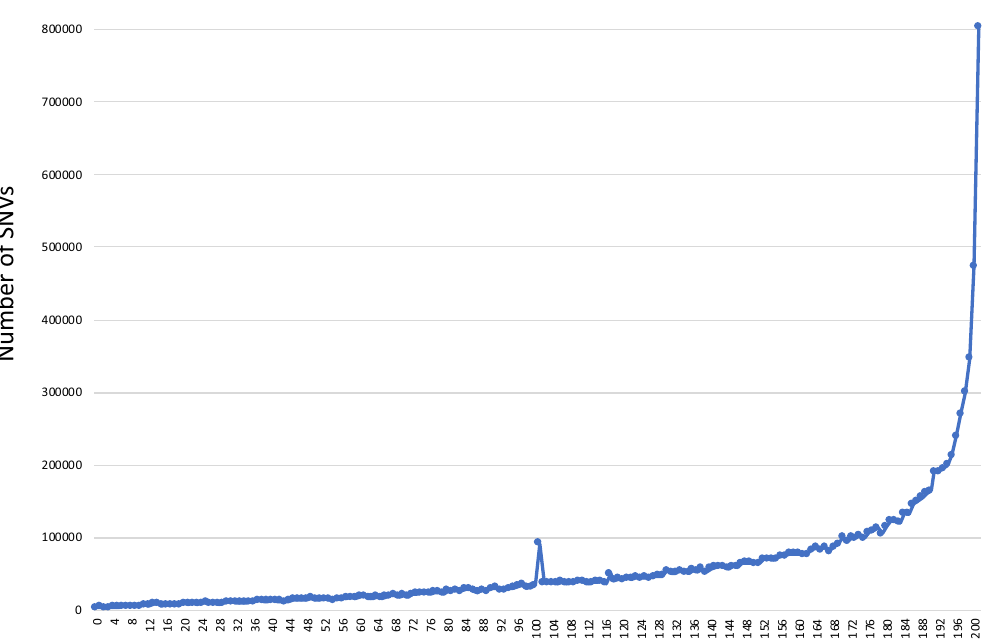
Figure 3. Allelic distributions of 11,570,312 SNVs identified on autosomes (ECA1-31) in the 101 Thoroughbreds. As can be seen on the right side, 802,454 SNVs (6.9%) had 201 REF-alleles and 1 ALT-allele in the 101 horses (total 202 alleles). A blip was observed at the position of 101 REF-alleles, which is equal to a minor allele frequency of